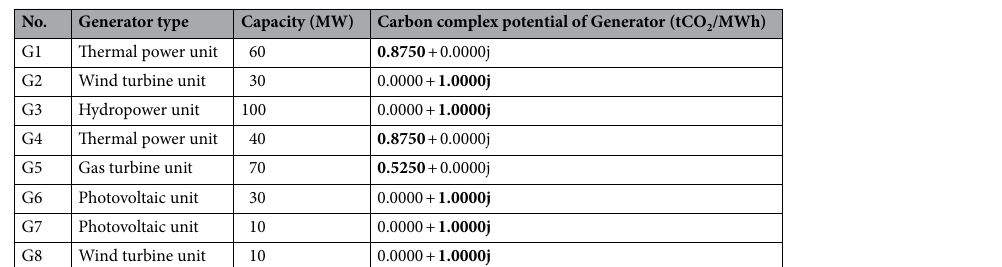
Table 6. Parameters of the generator of the 30-bus test system. Significance values are in bold.